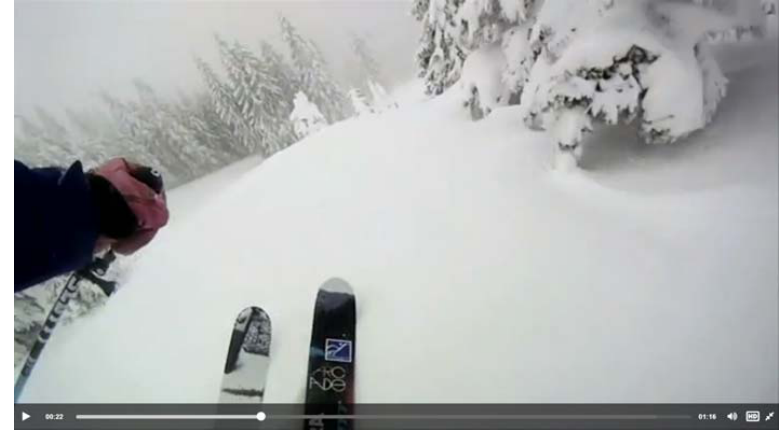
Figure 5. Still from the video Allure of the Backcountry .